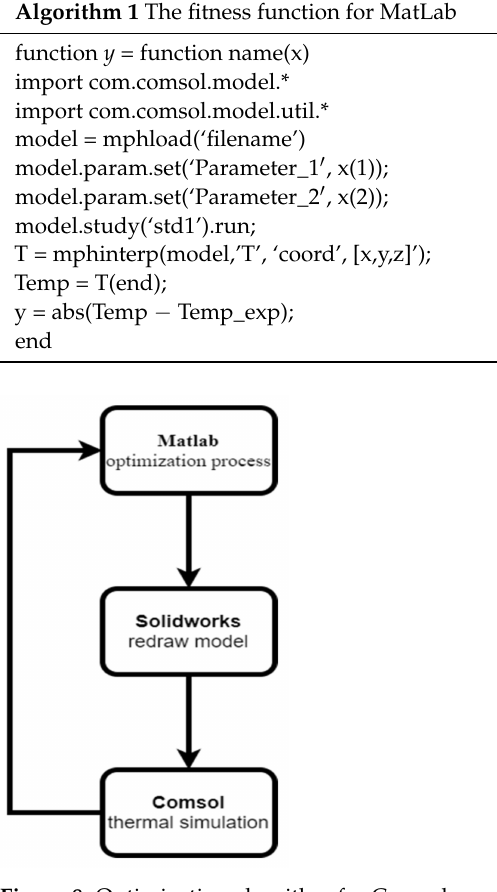
Figure 8. Optimization algorithm for